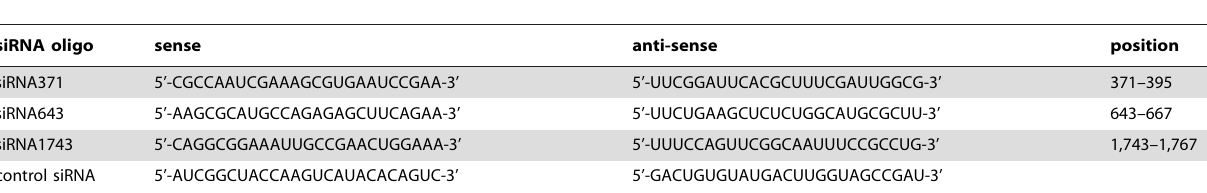
Table 1. The siRNA oligos used in this study.